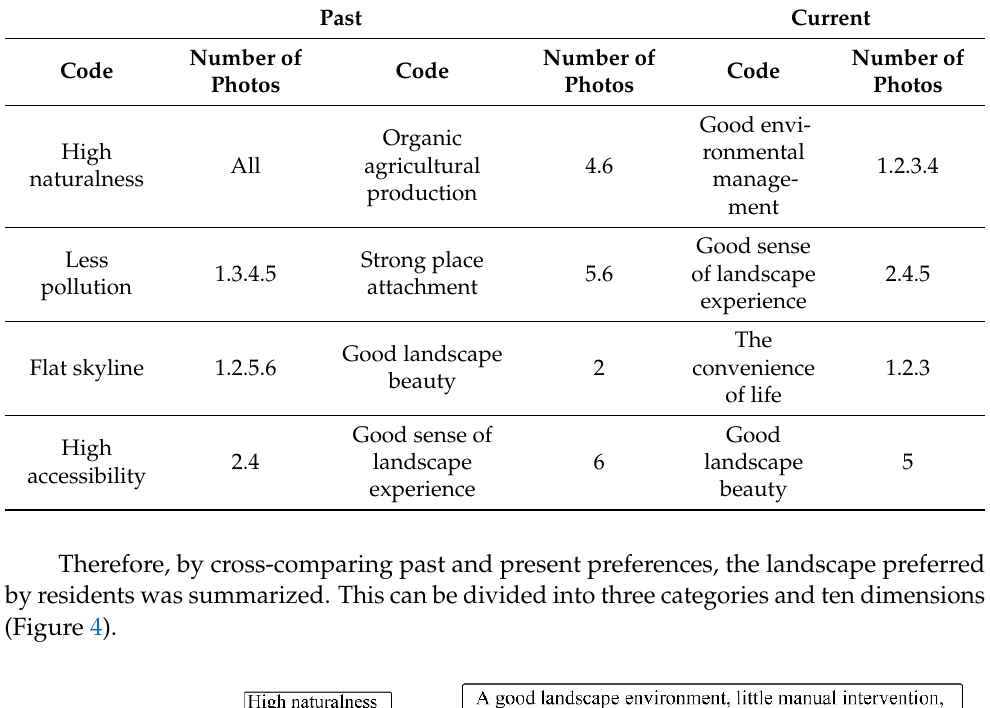
Table 5. Summary of reasons for environmental preference.